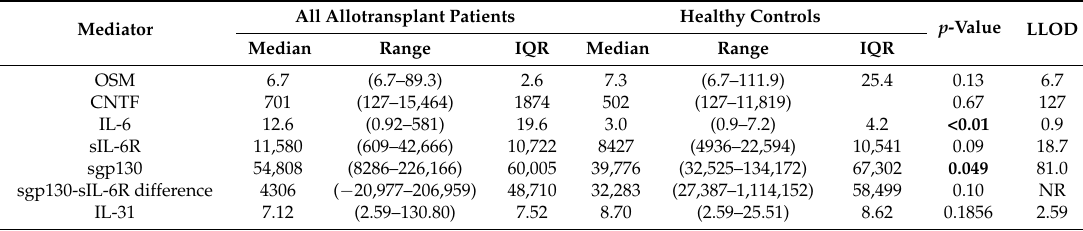
Table 2. Pretransplant serum levels of IL-6 family cytokines for the allotransplanted patients ( n = 100); a comparison with the levels for healthy individuals ( n = 14). Significant values ( p < 0.05) are highlighted in